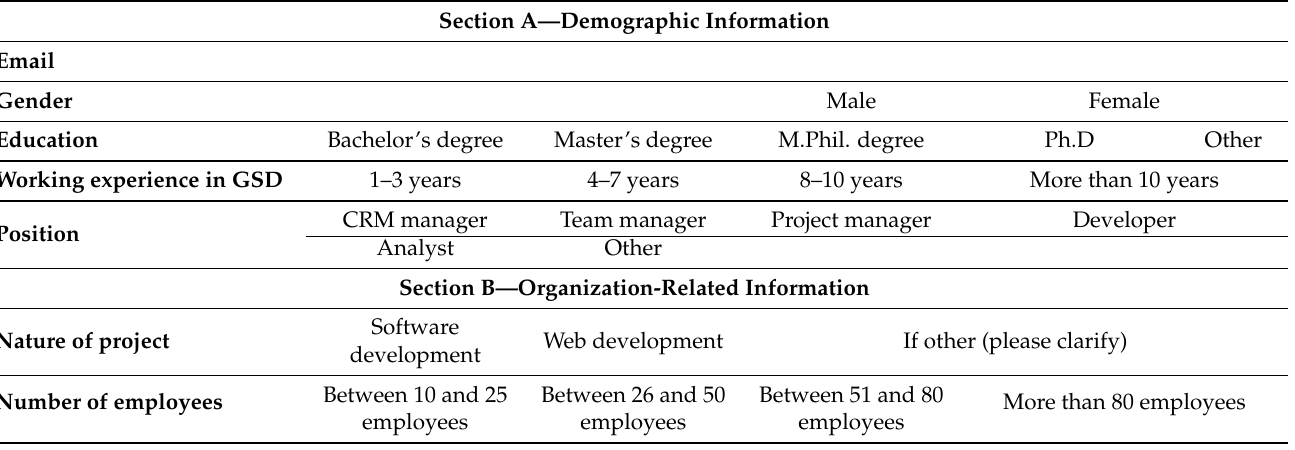
Table A2. Section C—Issues affecting CRM (customer relationship management) in GSD